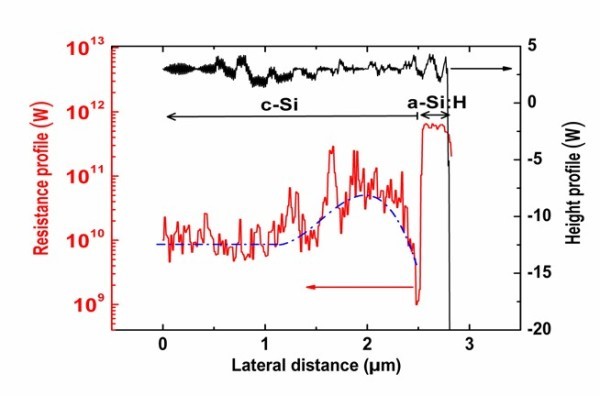
Profile of local resistance across the (n) a-Si:H/(p) c-Si interface corresponding to Figure 5.